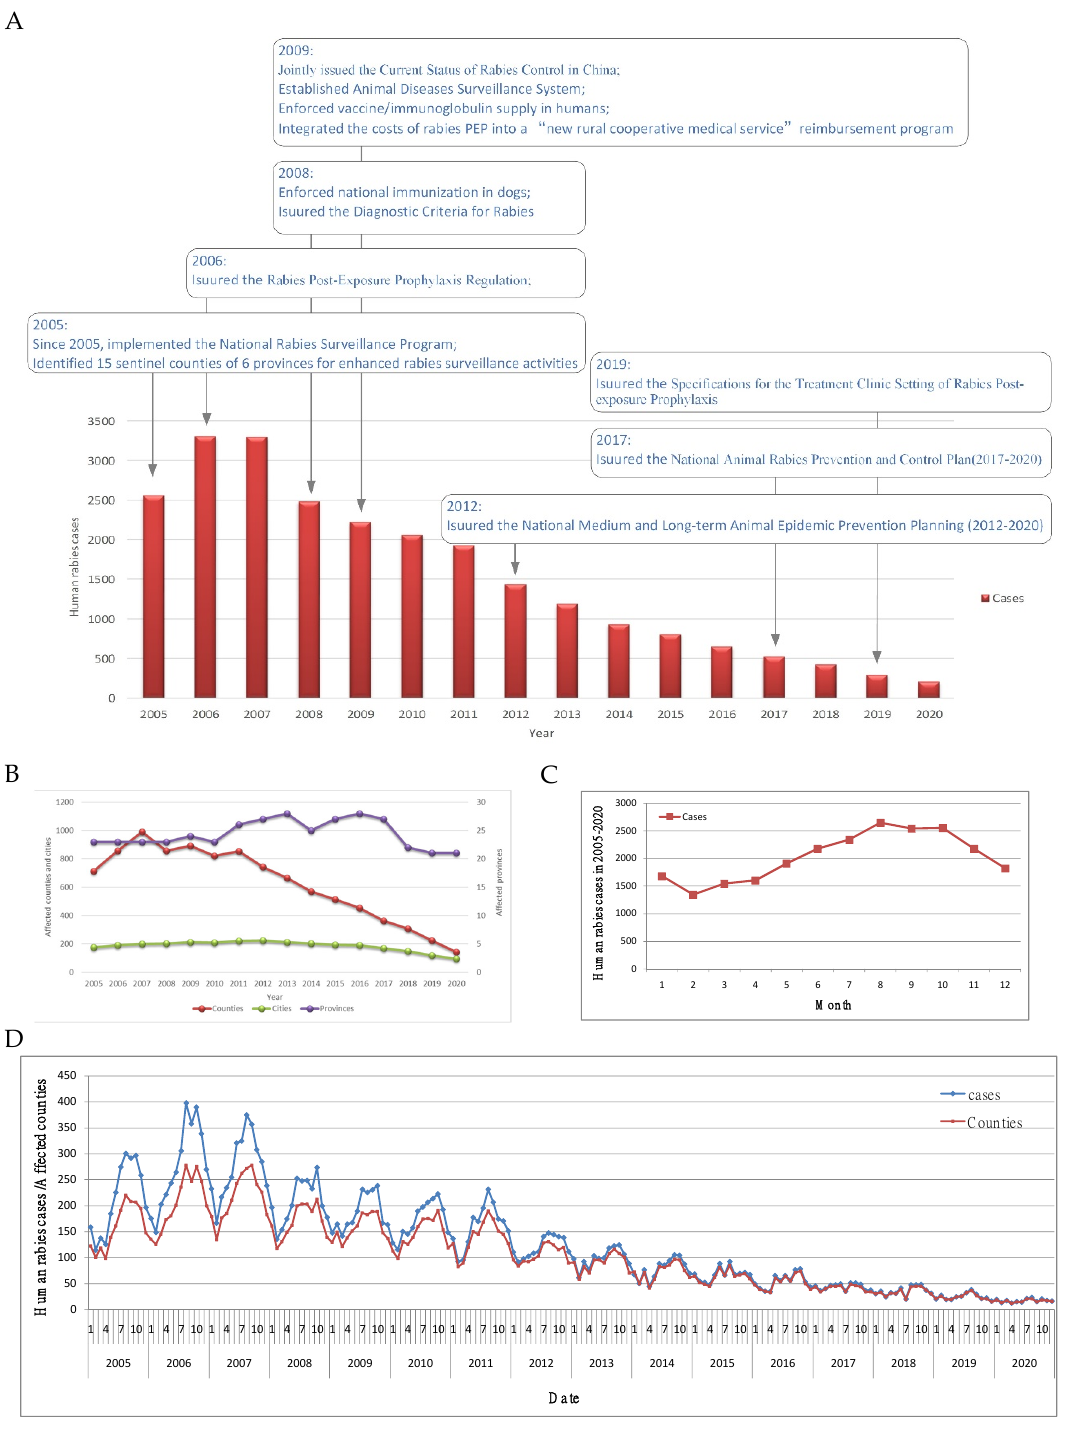
Figure 1. Time-series analyses of human rabies in mainland China, 2005–2020. ( A ) Yearly cases. ( B ) Affected areas. ( C ) Monthly cases in 2005–2020. ( D ) Monthly cases and affected counties.